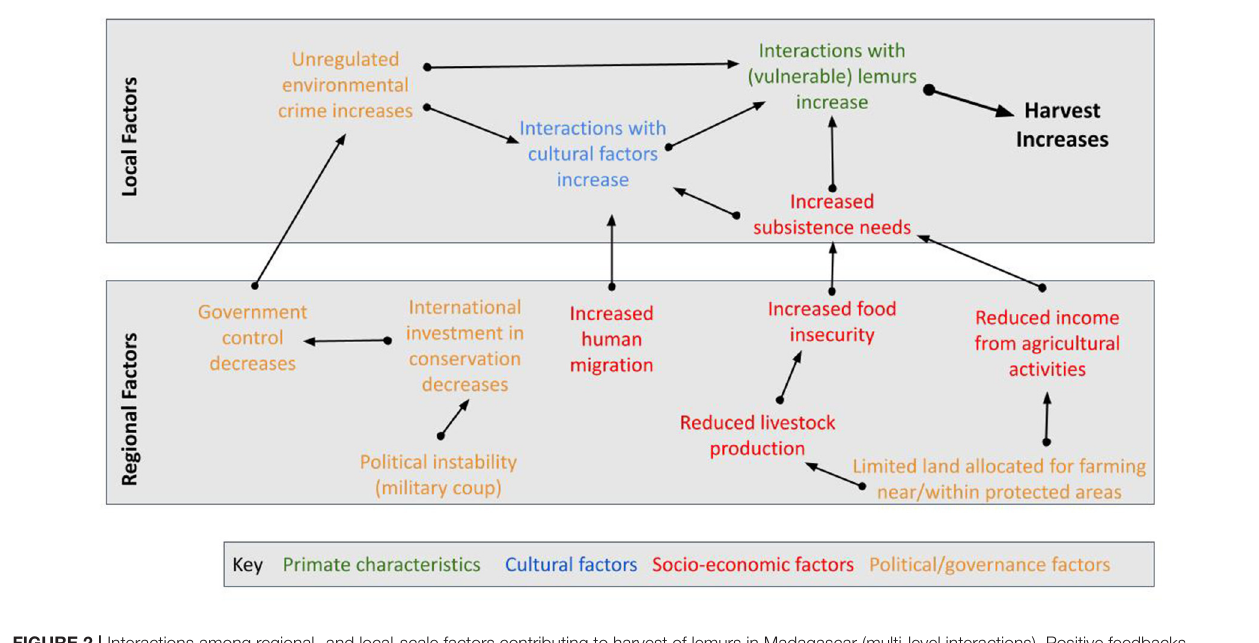
FIGURE 2 | Interactions among regional- and local-scale factors contributing to harvest of lemurs in Madagascar (multi-level interactions). Positive feedbacks (amplifying effects) on local harvest of lemurs by humans may result from political/governance (e.g., political instability, reduced agricultural investments) and socioeconomic (e.g., increased food insecurity, human migration) factors originating at the regional scale. The figure highlights opportunities for future studies on primate harvest in Madagascar (and beyond) to explicitly consider the impacts of regional factors on interactions with site-specific cultural factors and species-specific vulnerabilities to harvest. Figure adapted from Brashares et al.